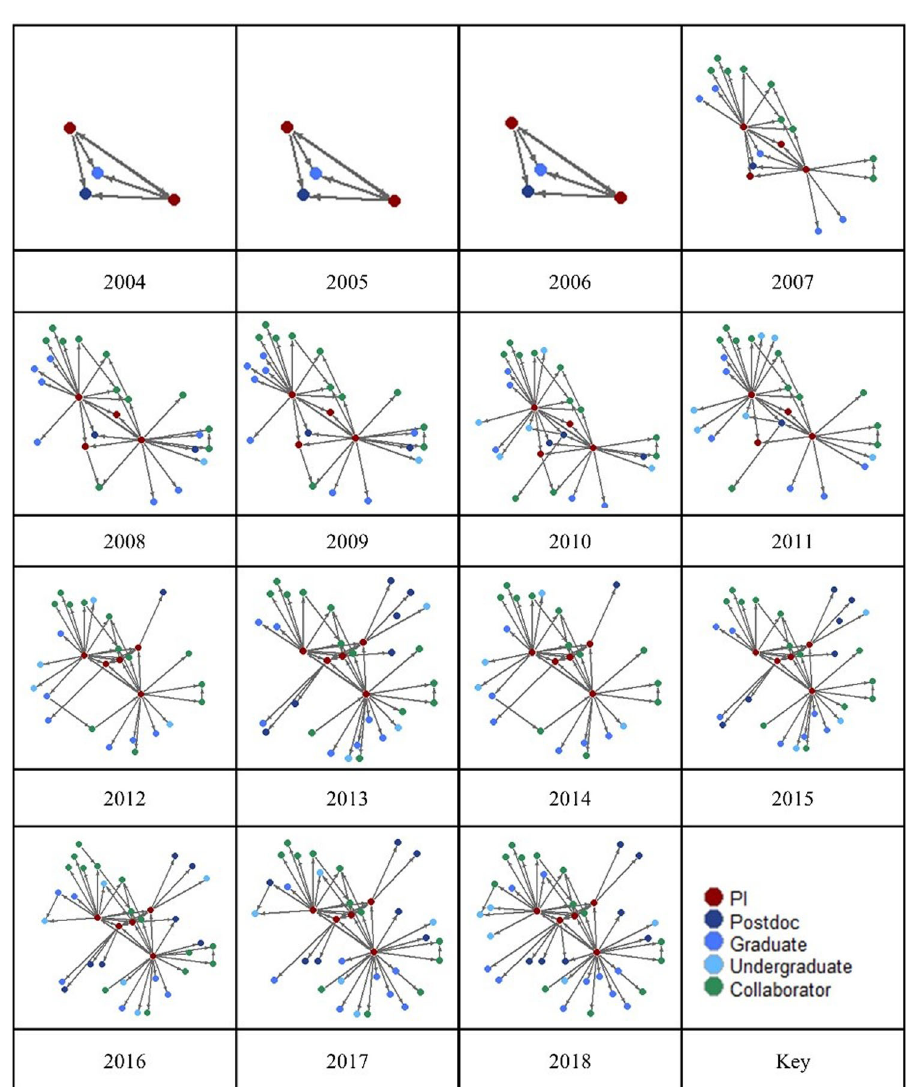
Fig. 3 Team longevity contributes to growth and development of scientists. Social network diagrams of team growth and development from 2004 – 2018. This network reports onboarding and integration of all members, including their primary position when they joined the team. The nodes are sized by average degree (see text). Colours denote different roles on the